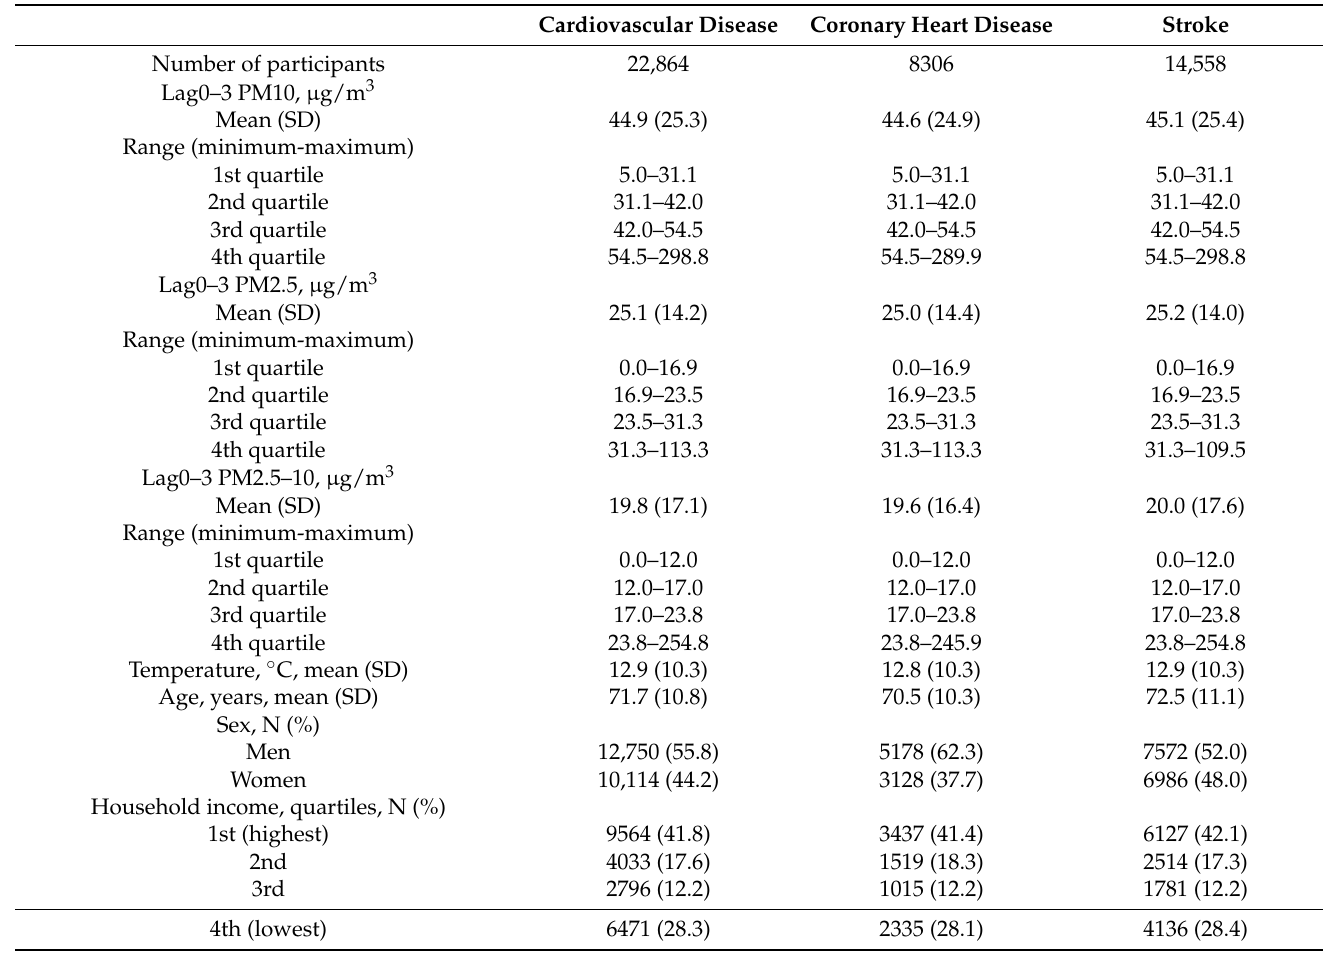
Table 1. Descriptive characteristics of the study